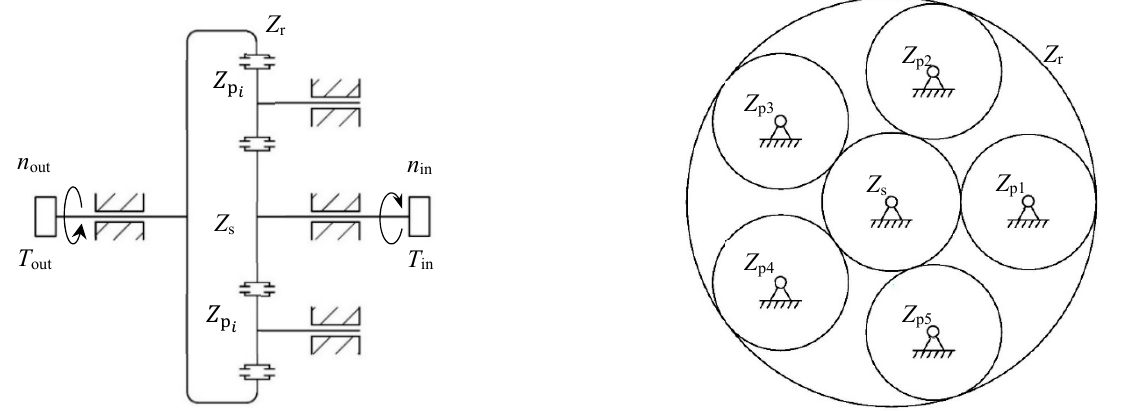
(2) Figure 3. Power splitting diagram of the star gear train. 3.2. The Meshing Force Analysis of the Five Star Gears In order to facilitate the mechanical analysis of the gear train, the center of the sun wheel is taken as the coordinate origin and the orientation of the center of star wheel 1 is taken as the positive direction of the x-axis, and the fixed coordinate system xoy is estab- lished, as shown in Figure 4. The five star wheels are evenly arranged, and the sun wheel rotates clockwise. Assuming that the input torque on the sun gear is T in , the meshing force between the sun gear and the star gear i is F sp i , and the torque generated by the force relative to the center of the sun gear is T sp i . The meshing force between the star gear i and the inner ring gear is F p i r , the torque generated by the force relative to the center of the sun gear is T p i r , and the output torque of the inner ring gear is T out . r bs , r bp i , and r br respectively